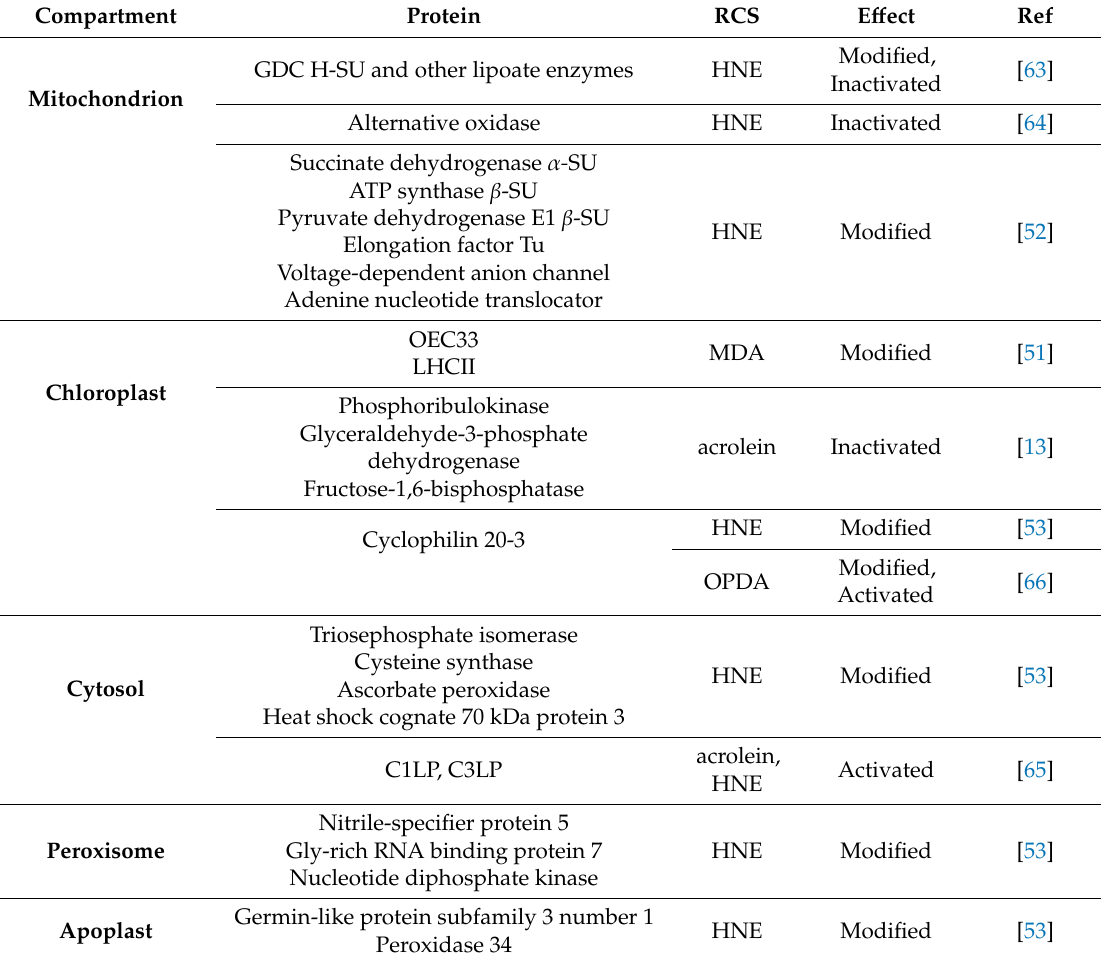
Table 1. List of plant proteins that are modified with RCS or inactivated by RCS. From the proteomic analyses [52,53], representative proteins are extracted. SU,